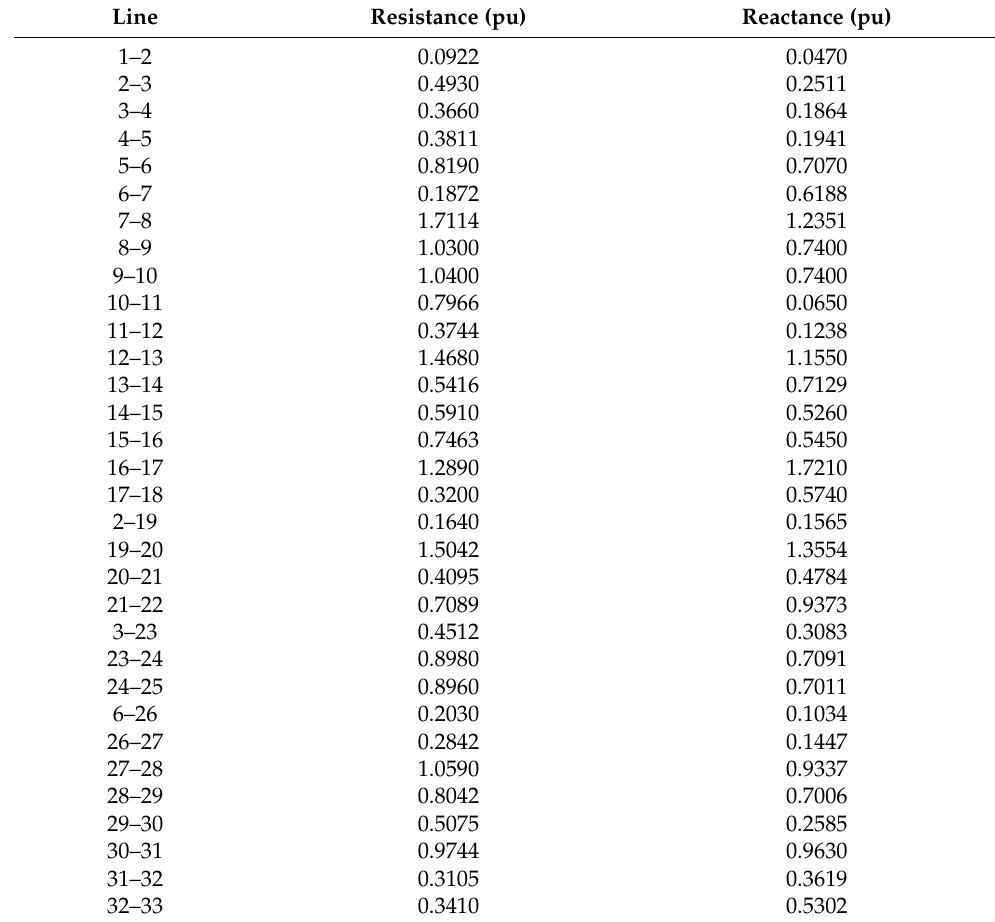
Table A4. Distribution line data of IEEE 33-bus test distribution